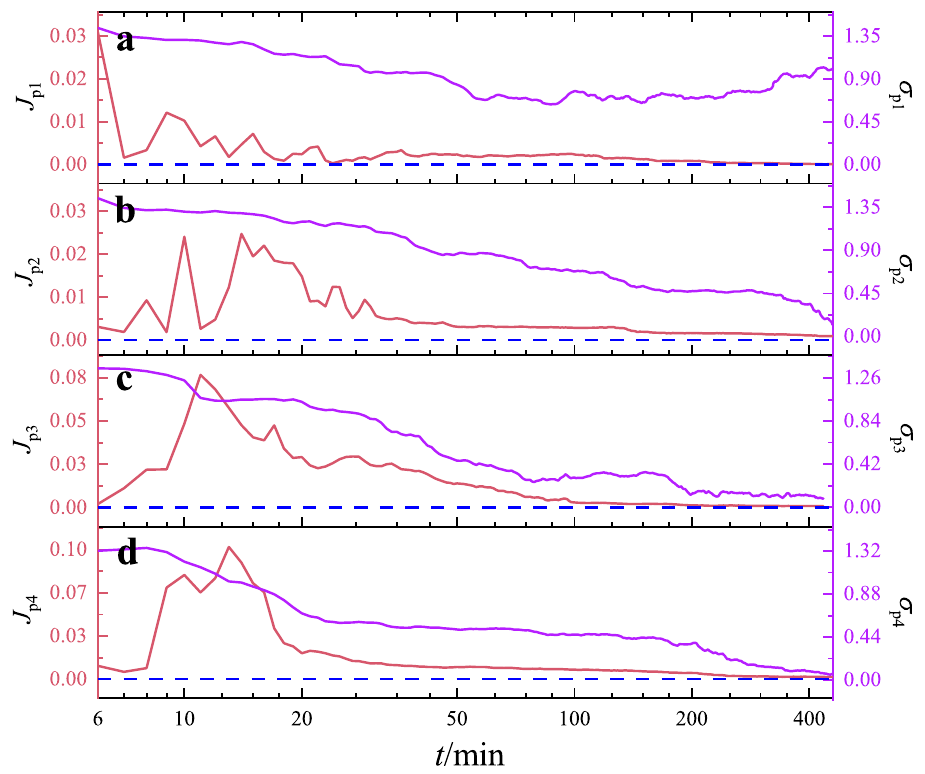
Figure 5. Comparison of training processes for four types of PBC loss functions. The red line and the red Y-axis on the left represent the change of the loss functions, while the purple line and the purple Y-axis on the right represent the standard error between the network results and analytical solutions.